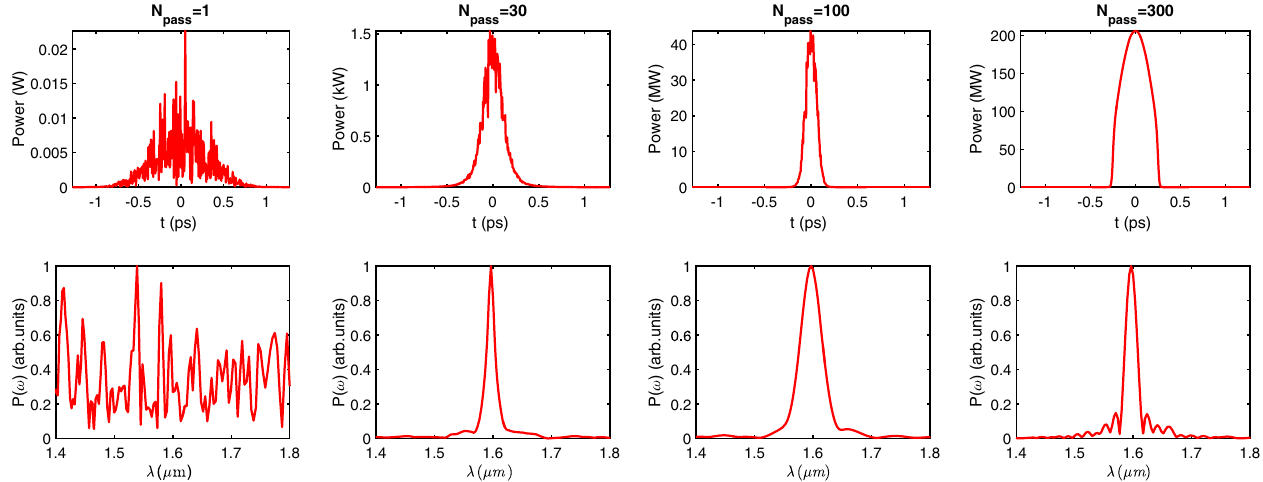
FIG. 5. Snapshots of output radiation pulse for a typical infrared FELO at 1 . 6 μ m. The top and the bottom row show the longitudinal pulse temporal profile and corresponding spectrum respectively